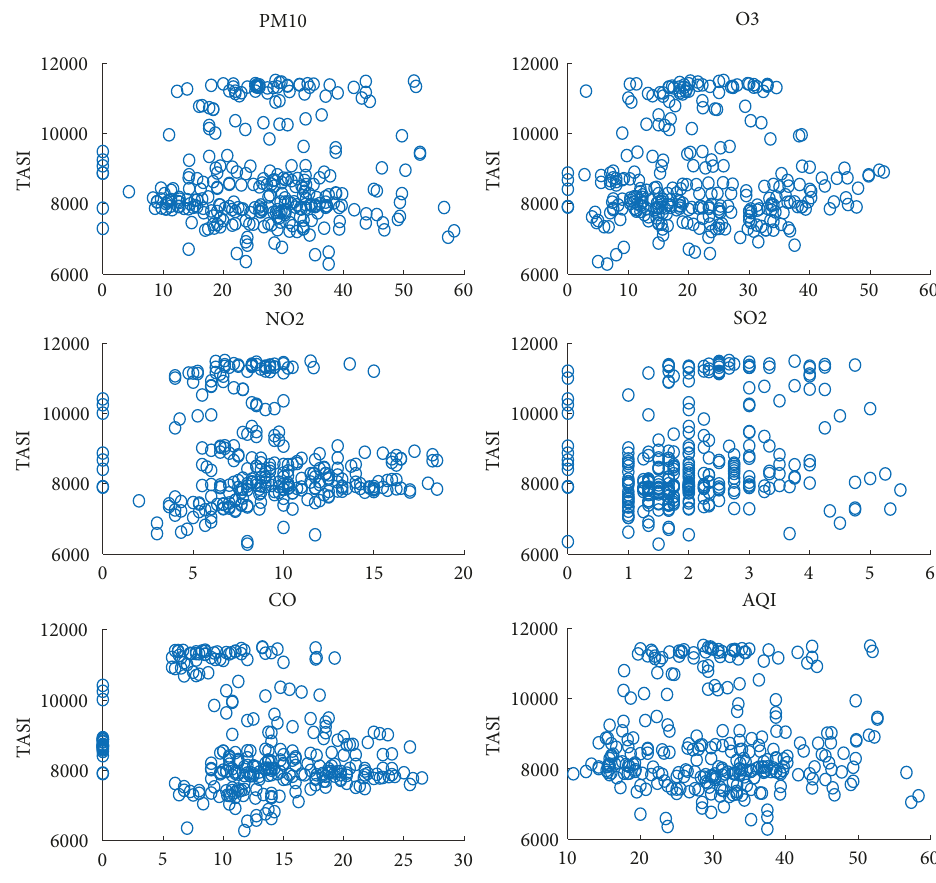
Figure 2: The relationship between the leading pollutant indices and the TASI index.